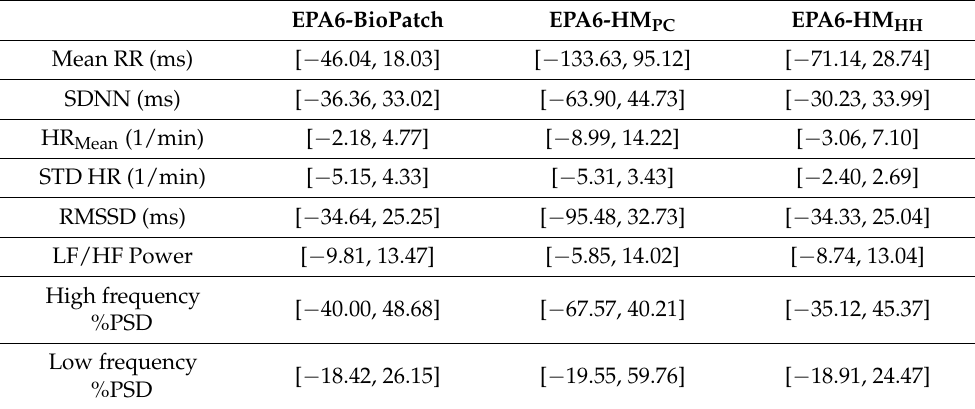
Table 1. Bland–Altman limits of agreement for seven measures averaged over five behavioral con- ditions are shown. A detailed specification for each behavioral condition which includes the 95% confidence intervals of the lower and upper limits of agreement is given in the supplementary mate- rial.